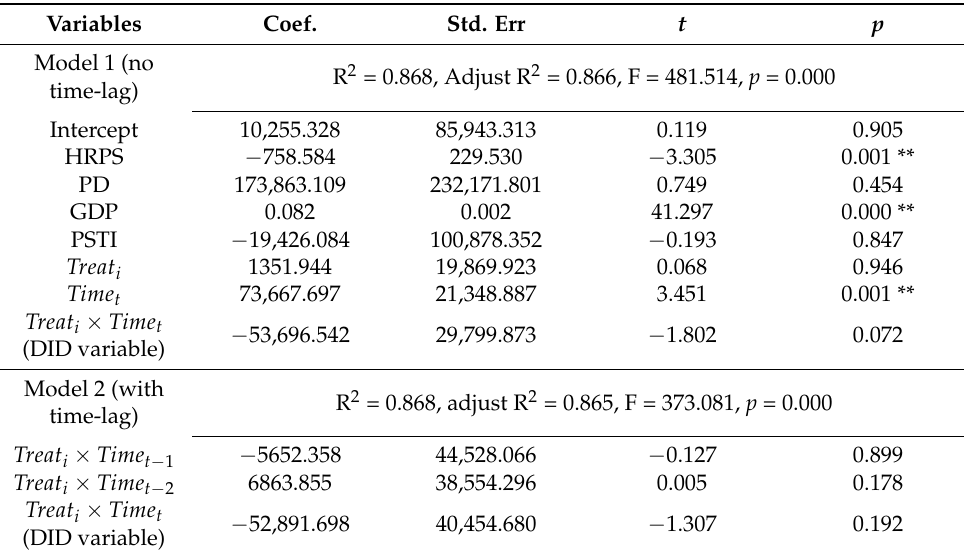
Table 4. Estimation results of PSM-DID model.